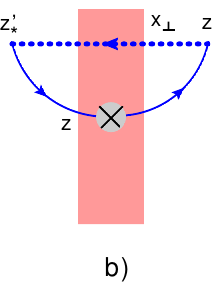
ˆ Q 1 x and 5 x